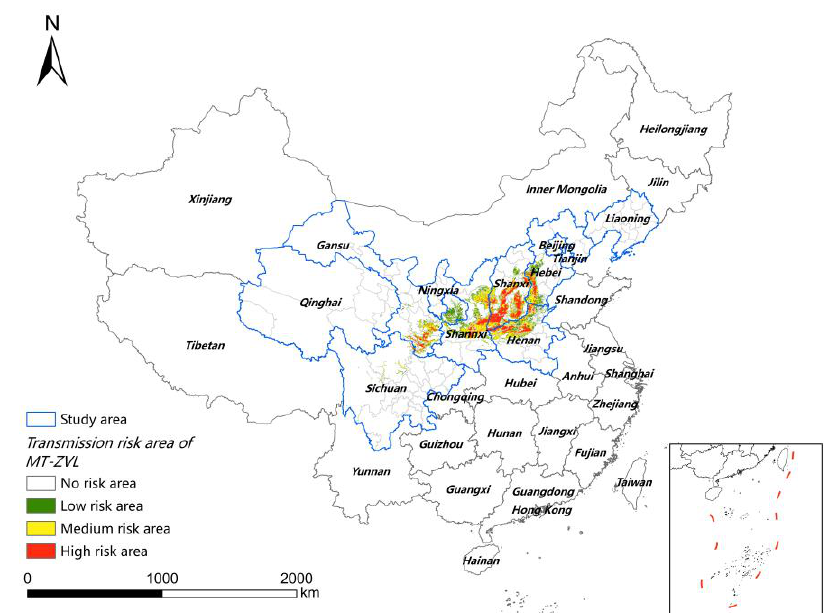
Figure 5. Areas at risk of mountain-type zoonotic visceral leishmaniasis transmission in China predicted with ensemble ecological niche models based on climatic and environmental variables.